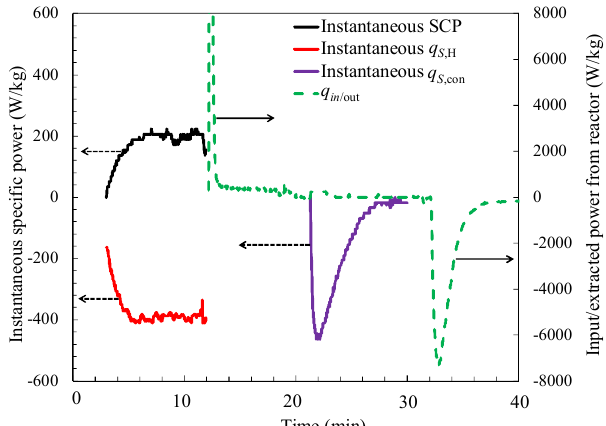
Figure 9. Instantaneous specific cooling and heating power as a function of time. SCP—specific cooling power.